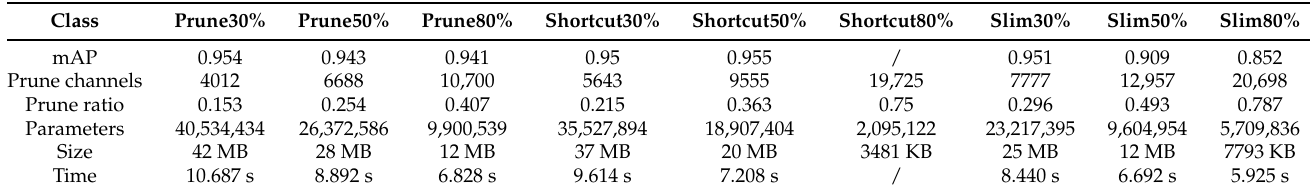
Table 7. Performance using sparse training Method B on